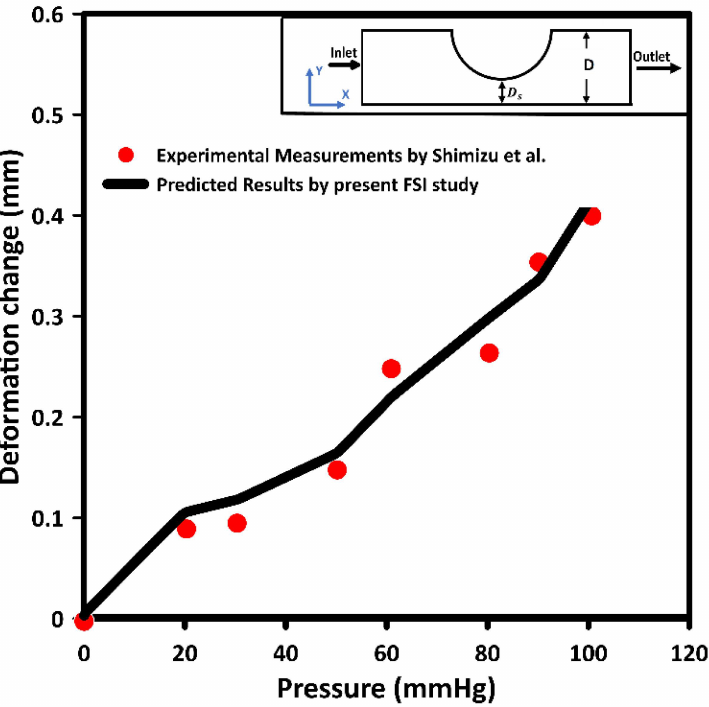
Figure 3. Validation of current calculated deformation changes with those of Shimizu et al. [47] at the narrowest segment of a stenotic